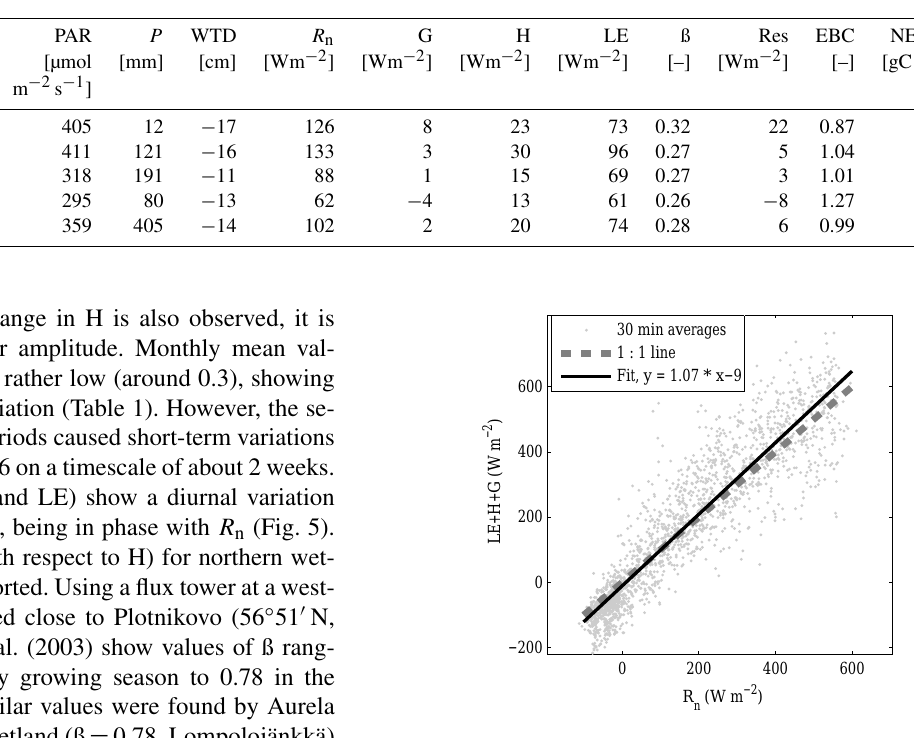
Figure 6. Energy balance plot. The sum of latent and sensible heat fluxes and soil heat flux is plotted against net radiation flux. A linear function is fit to the data and shown together with a 1 : 1 line. The mean ratio of LE + H + G to R n is